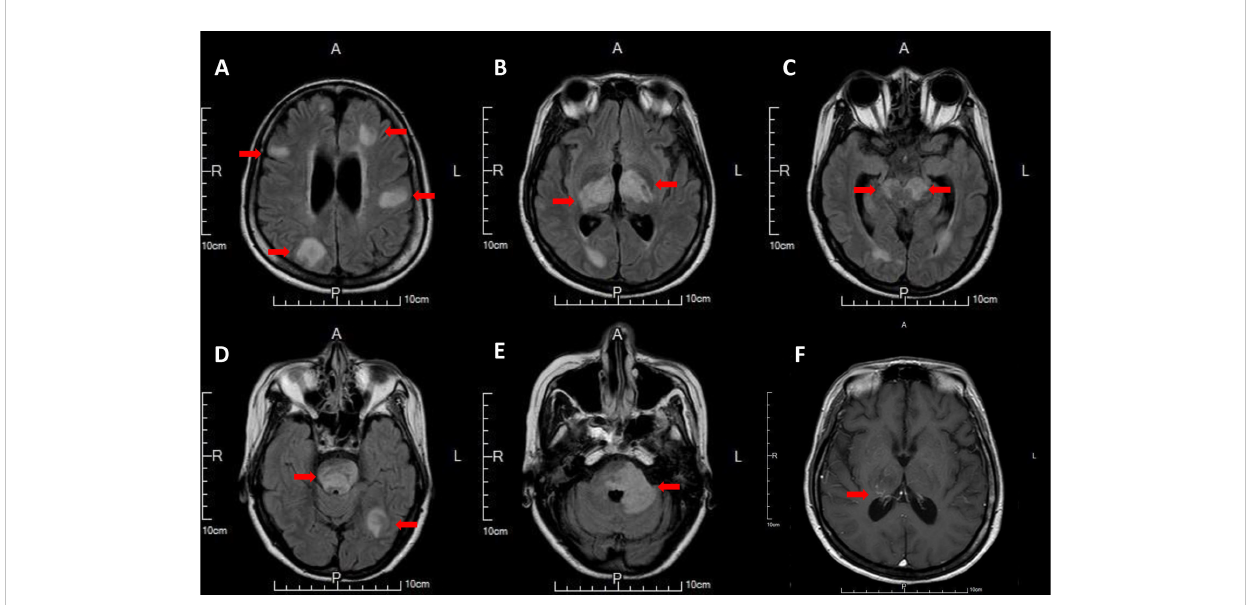
FIGURE 3 Multifocal hyperintense lesions involving subcortical white matter of bilateral hemisphere (A) , posterior limb of internal capsule and thalamus (B) , cerebral peduncle and periventricular white matter of temporal horn (C) , pontine and subcortical white matter of left temporo-occipital lobe (D) , left middle cerebellar peduncle (E) on T2 fl uid attenuated inversion recovery brain MRI, with faint contrast enhancement involving right thalamus on post-contrast T1-weighted image (F)